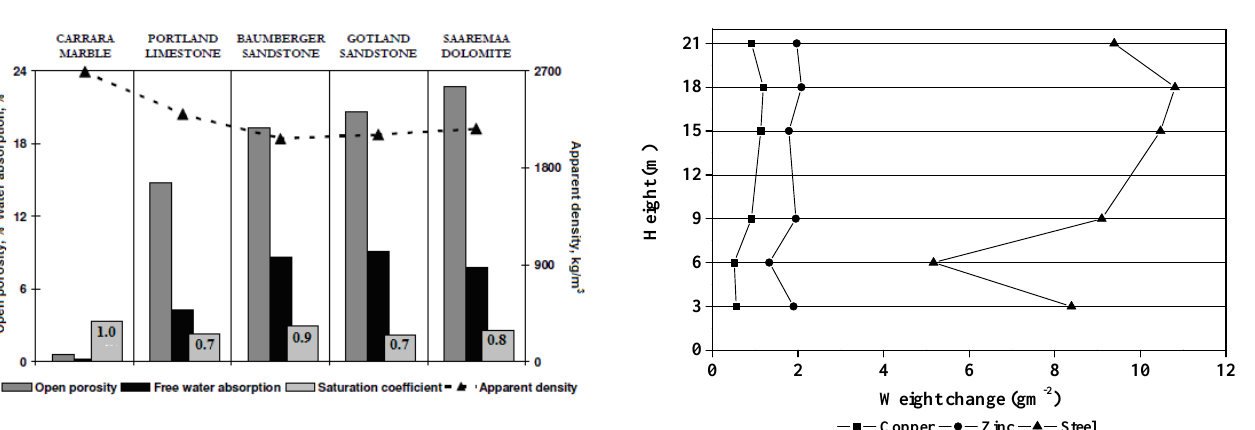
Fig. 2. Physical properties of stone materials.